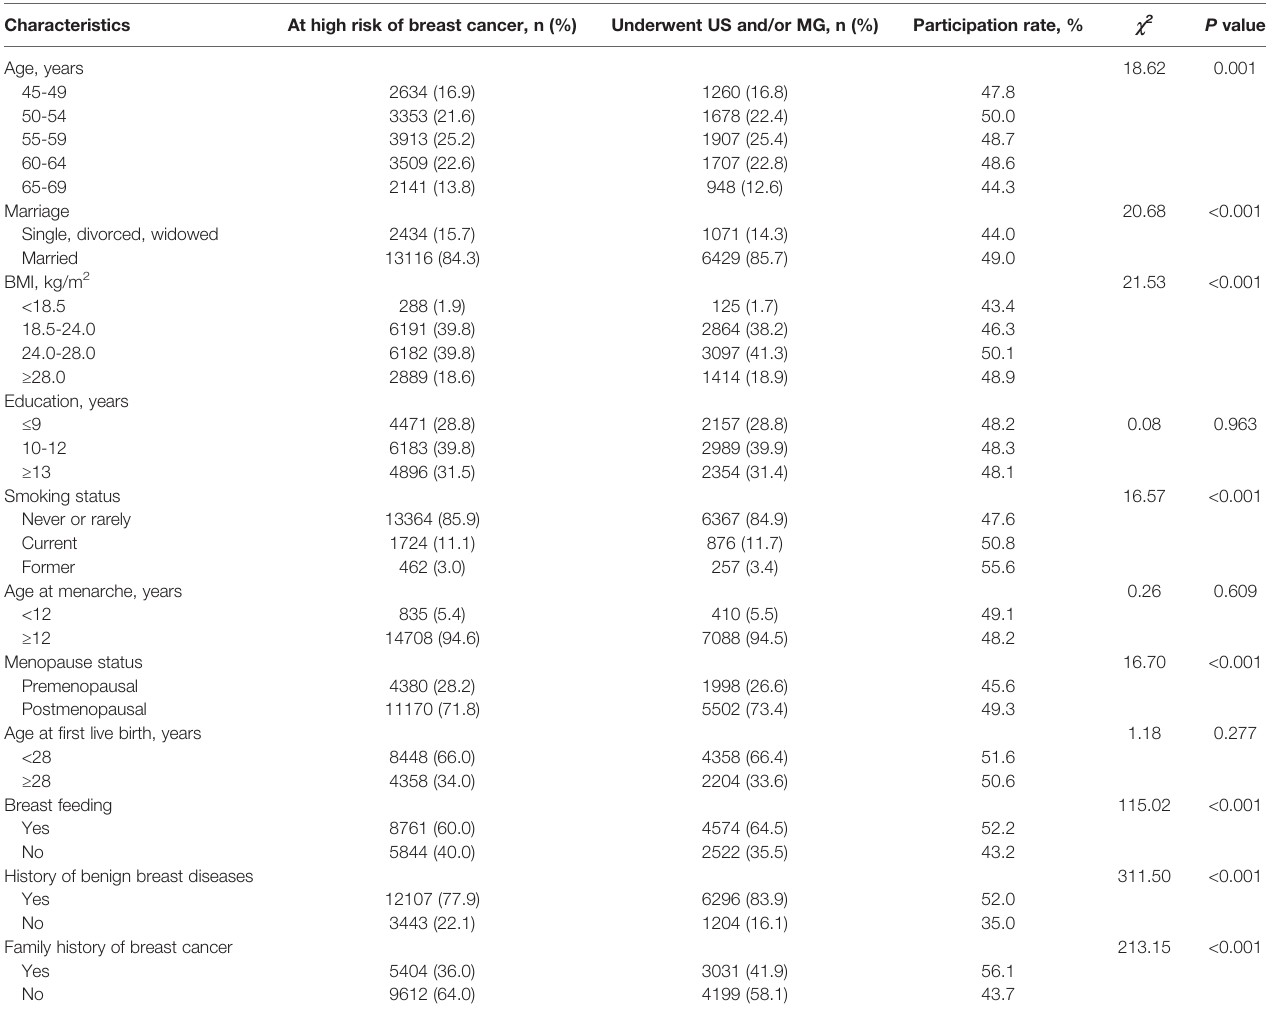
TABLE 1 | Characteristics of the women and participation rates. Characteristics At high risk of breast cancer, n